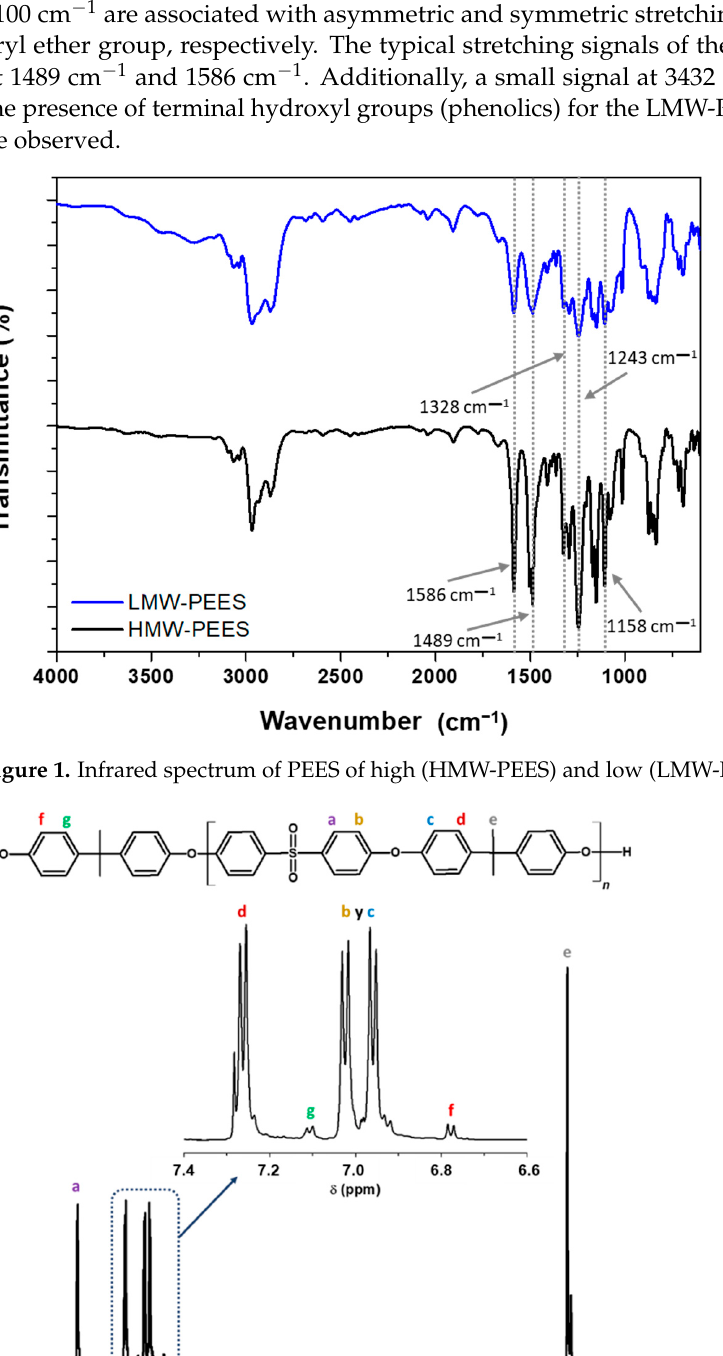
Figure 2. Structure and 1 H NMR spectrum of LMW-PEES sample.